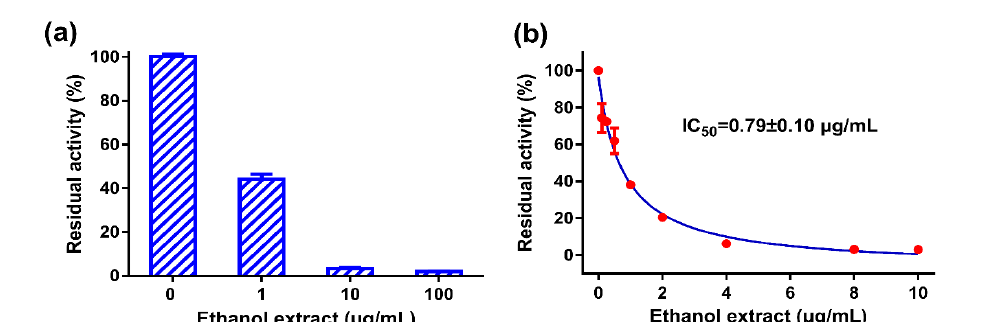
FIGURE 1 - (a) Inhibitory effects of P. cuspidatum ethanol extract (0, 1, 10, 100 μg/mL) on EcGUS-mediated DDAOG hydrolysis, and (b) the corresponding dose-dependent inhibition curve of different concentrations of P. cuspidatum ethanol extract against EcGUS-mediated DDAOG hydrolysis. All data represent the mean of triplicate